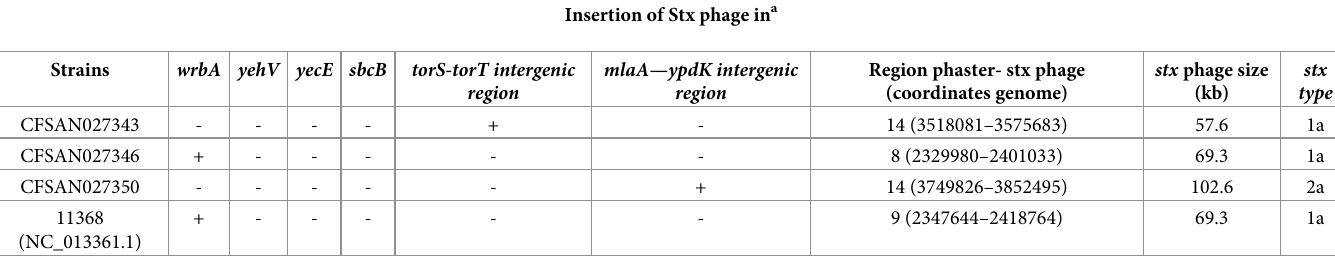
Table 8. Identification of chromosomal insertion sites for stx phages in the 3 STEC O26:H11 MinION genomes, their stx gene type, regions and coordinates in the genome, and their stx phage sizes.